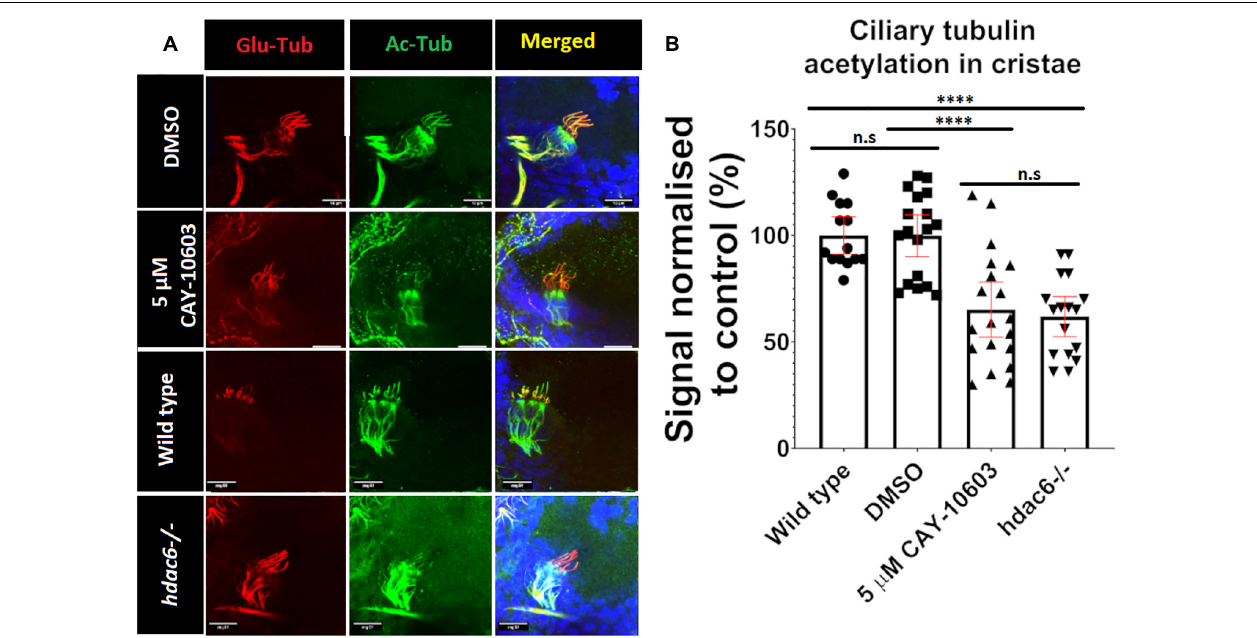
FIGURE 4 | Chemical inhibition of Hdac6. (A) Effects of 72-h treatment with 5 µ M CAY-10603 hdac6 inhibitor and hdac6-/- mutation on tubulin acetylation in cristae cilia of 3 dpf old embryo. (B) Tubulin acetylation level normalized to wt. Arrowheads point cilia. ( t -test **** p < 0.0001. ns, no significant. n wt = 32 n hdac 6 = 17 n CAY 10603 = 19).